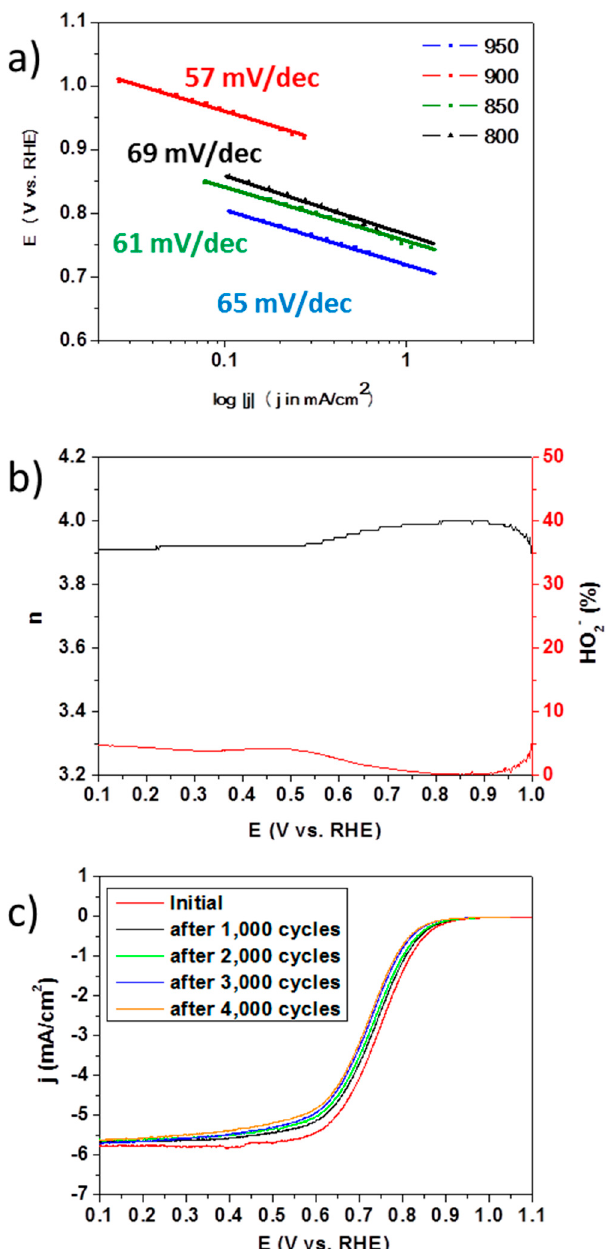
Figure 6. ( a ) Tafel slopes of the Fe ‐ N ‐ C catalysts prepared by different pyrolysis temperature, ( b ) number of electron transferred and HO 2 − yield during the ORR catalyzed by Fe ‐ N ‐ C and ( c ) accelerated durability testing (ADT) of Fe ‐ N ‐ C; initial, after 1,000, 2,000, 3,000, and 4,000 potential cycles in O 2 ‐ saturated 0.1 M KOH.